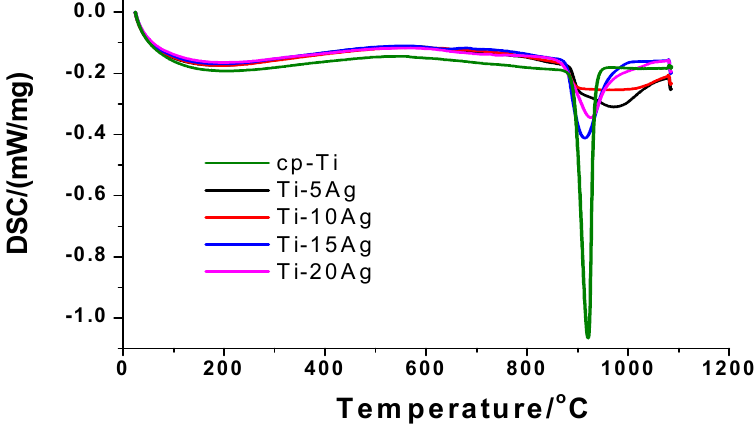
Figure 6. Differential scanning calorimetry (DSC) curves of the cast cp-Ti and series of binary Ti– x Ag alloys.